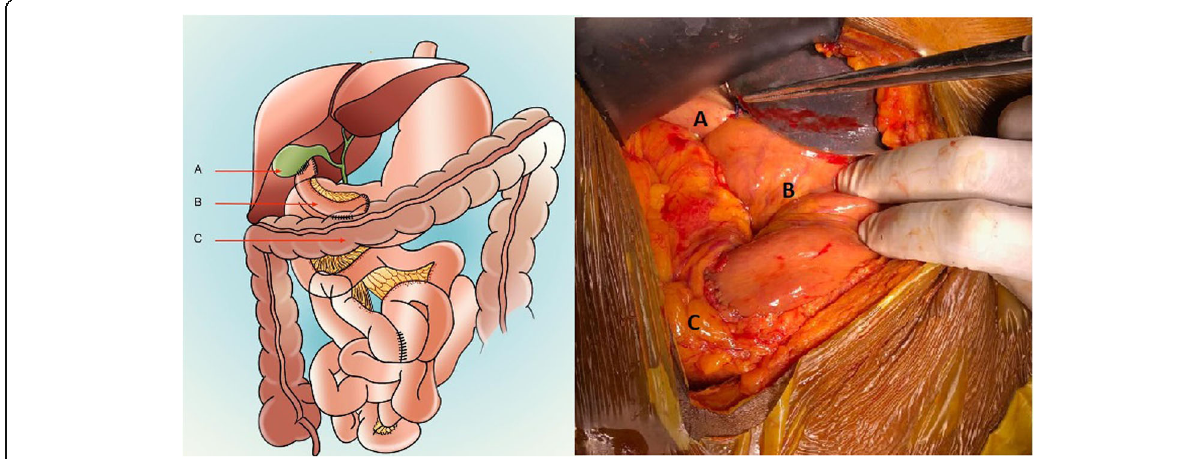
Fig. 1 Biliary diversion: A 40-cm mid jejunal loop ( b ) was taken retrocolic to the supracolic compartment. Superiorly to the gall bladder fundus ( a ) and inferiorly to the proximal transverse colon ( c ) was anastomosed to the